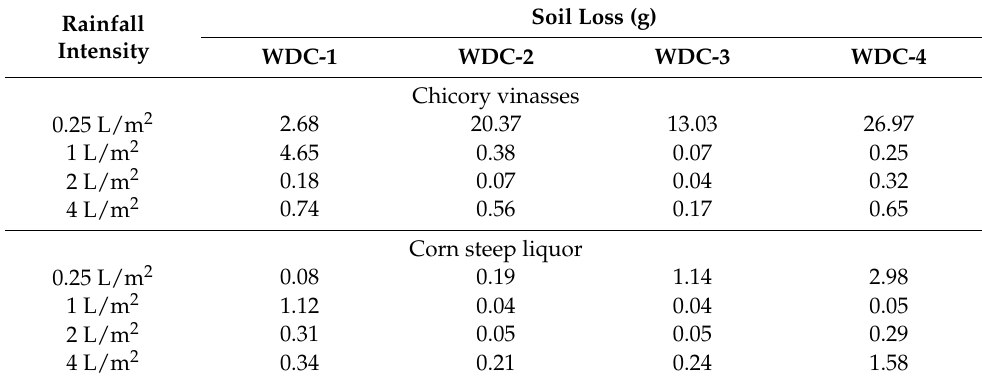
Table A3. Summary of soil loss (g) from treated mine soils after each wet–dry cycle at different rainfall intensities (arithmetic mean, n =